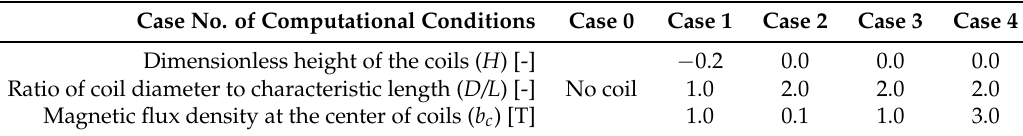
Table 1. Computational conditions for coils.